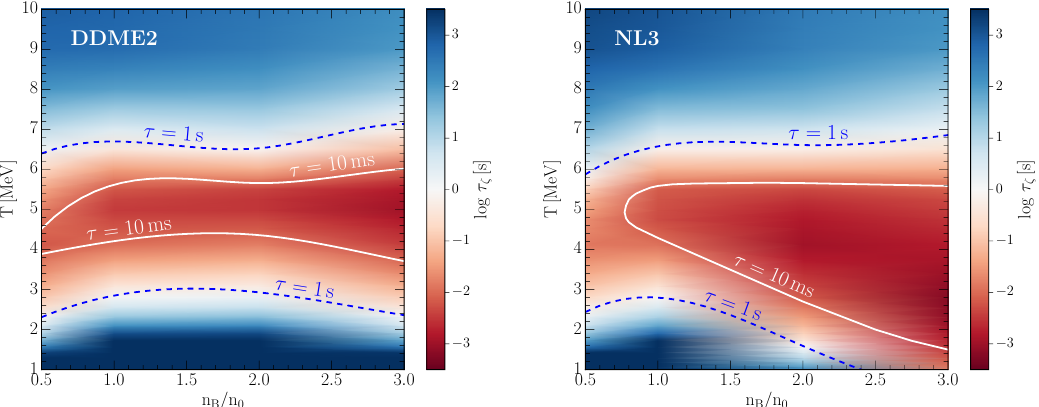
Figure 10. Bulk viscous damping timescale as a function of the density and temperature for model DDME2 ( left panel ) and model NL3 ( right panel ). The density oscillation frequency is fixed at f = 1 kHz. The white solid lines correspond to the characteristic timescale τ = 10ms, the blue dashed lines - to the timescale τ = 1s. The areas colored in red are the regions where the bulk viscous dissipation becomes important in the dynamics of neutron star mergers.